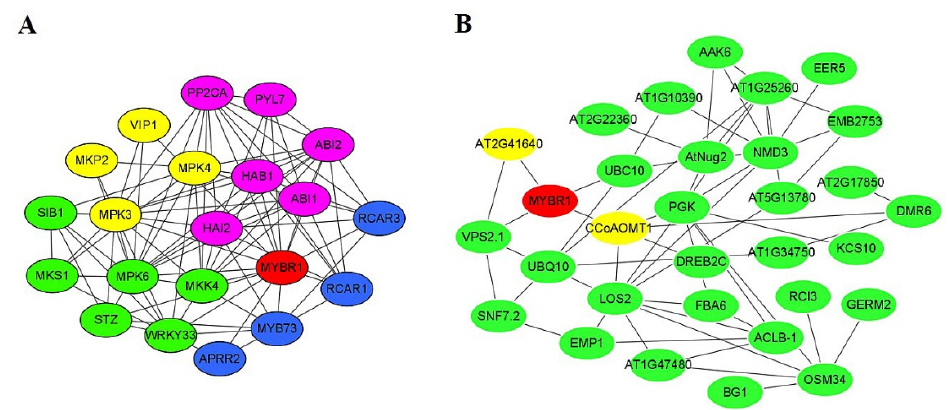
Figure 6. Protein–protein interaction networks of A. thaliana MYBR1 transcription factor predicted by STRING ( A ) and Cytoscape ( B ). In the STRING-based network, proteins involved in defense responses and enzyme regulation are shown in green; proteins involved in ABA receptor pathways are shown in pink; proteins involved in kinase signaling transduction and activation are shown in yellow; proteins involved in stress responses are shown in blue. In the Cytoscape-based network, CCoAOMT1 protein and AT2G41640 protein in yellow represent homologous proteins of CCoAOMT2 and XYXT1, respectively.